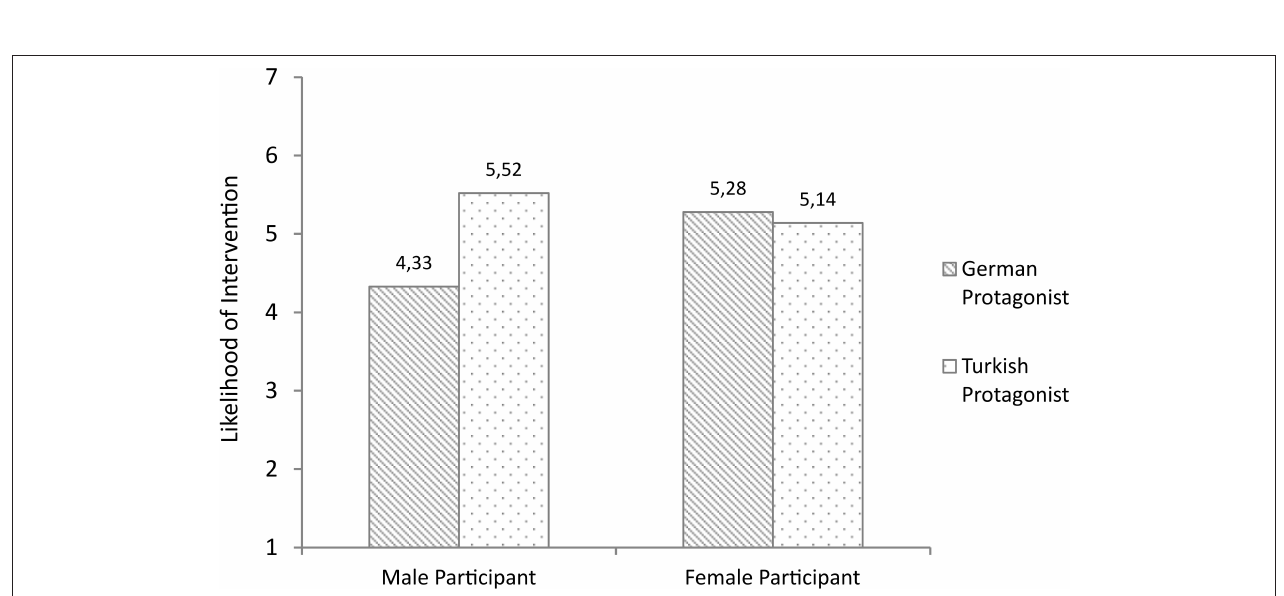
FIGURE 2 | Likelihood of intervention as a function of participants’ gender and origin of the protagonist. Note: High numbers indicate a high likelihood to intervene into the situation.